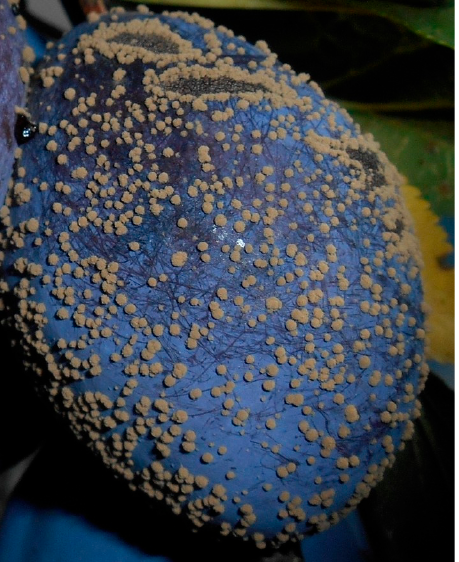
Figure 5. Plum fruit with the typical symptoms of brown rot.